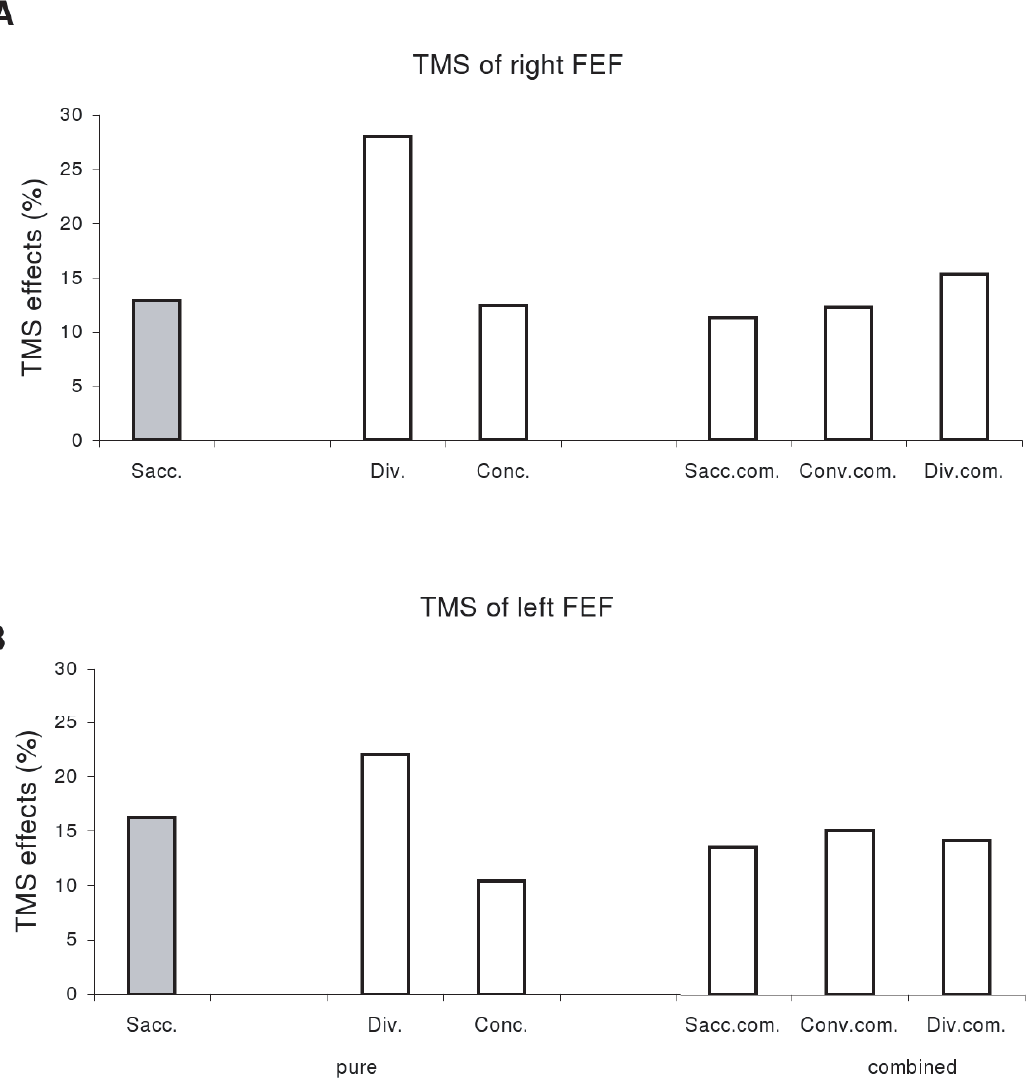
Figure 2. Mean values of percentage of TMS effects in latency, (TMS-noTMS)/noTMS. (A) TMS of right FEF and (B) TMS of left FEF for divergence, saccades, convergence, and saccade components, convergence components and divergence components of combined movements under the conditions of TMS over the right or the left FEF. Such value is higher for divergence than for any other types of eye movements.